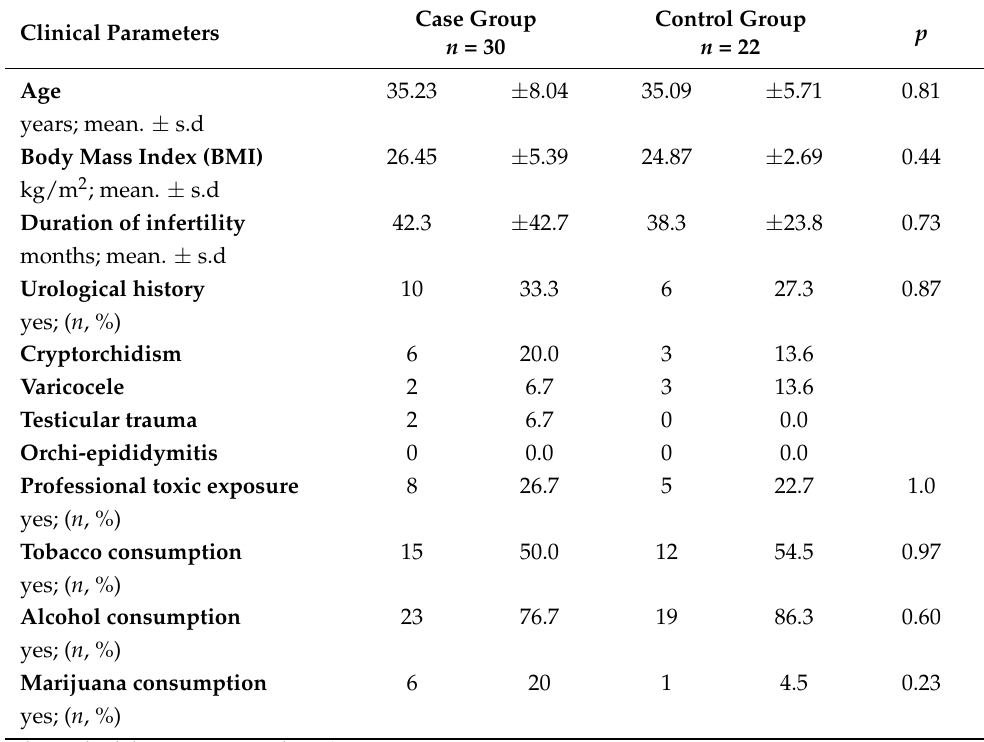
Table 1. Clinical parameters in case and control